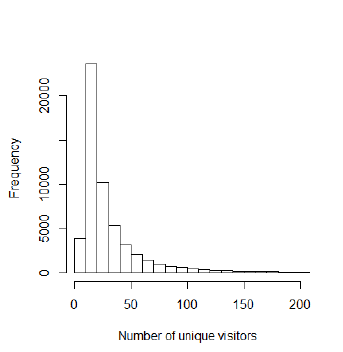
Figure 2: Histogram of the number of unique visitors per Tweet place